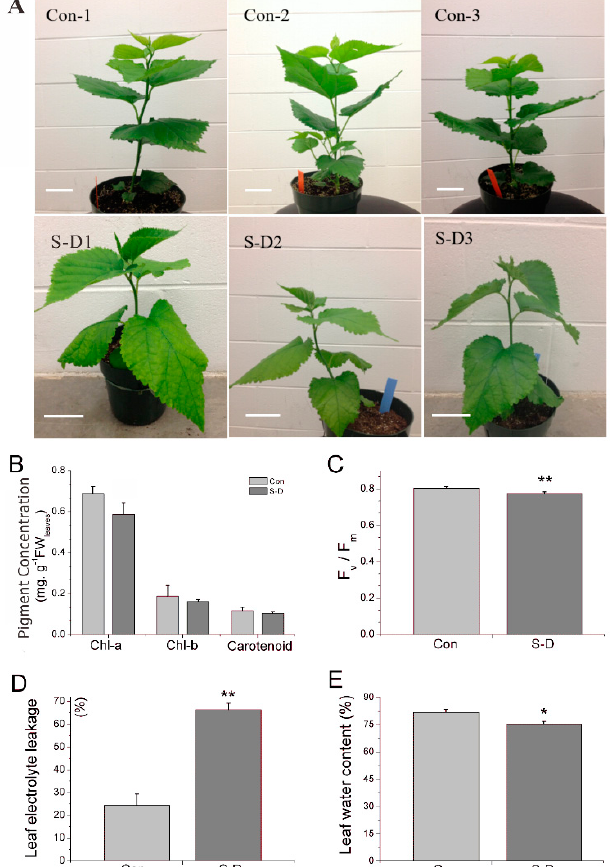
Figure 1. Physiological responses of mulberry to a combination of salt and drought stress. ( A ) Growth phenotype of mulberry seedlings at the end of a combination of salt and drought stress. These plants were treated with 200 mM NaCl for two days and continued dehydration for two weeks. Scale bar = 5 cm. ( B ) Chlorophyll content (Chl-a, Chl-b, and carotenoid, mg. g − 1.FW) in both the control (Con) and salt-drought stress groups (S-D). ( C ) Chlorophyll fluorescence parameter F v / F m in both Con and S-D group. ( D ) Leaf electrolyte leakage (%) in Con and S-D group. ( E ) Leaf water content (%) in both Con and S-D group. The values of each column are the means ± S.D. of three biological replicates. Asterisks labeled above the columns indicate a significant difference at the p ≤ 0.05 level by Duncan’s test using SPSS software (version 22.0).